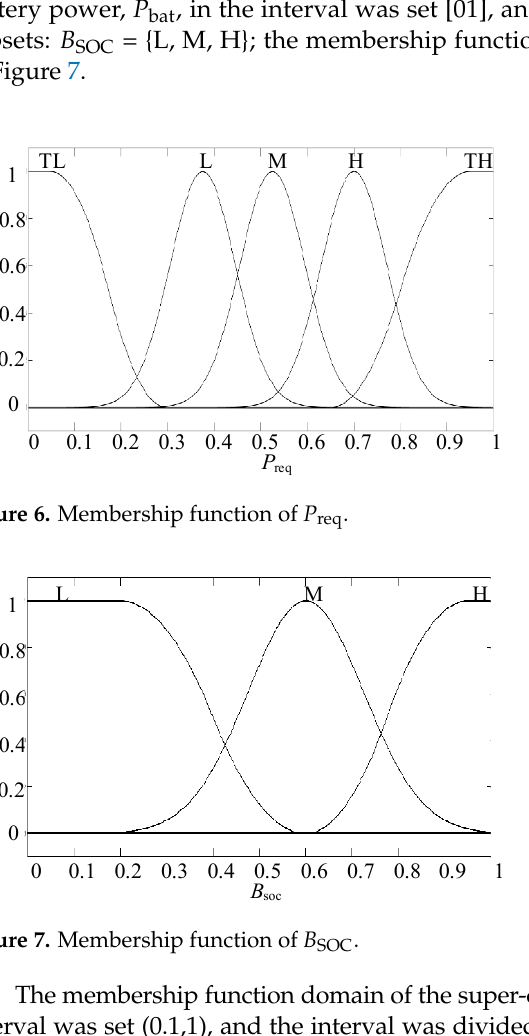
Figure 8. The membership function domain of the supercapacitor’s power distribution factor, K SC , in the interval was set (0.1,1), and the interval was divided into five subsets: K SC = {TL, L, M, H, TH}; the membership function of the super-capacitor power distribution factor is shown in Figure